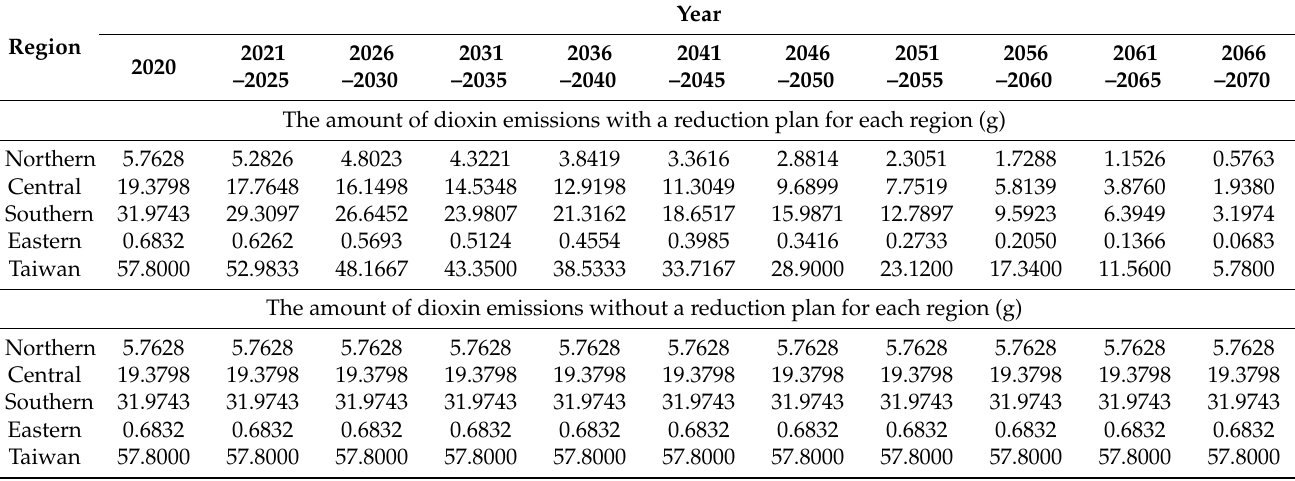
Table 7. The reduction in dioxin emissions for each 5-year interval from 2021 to 2070.